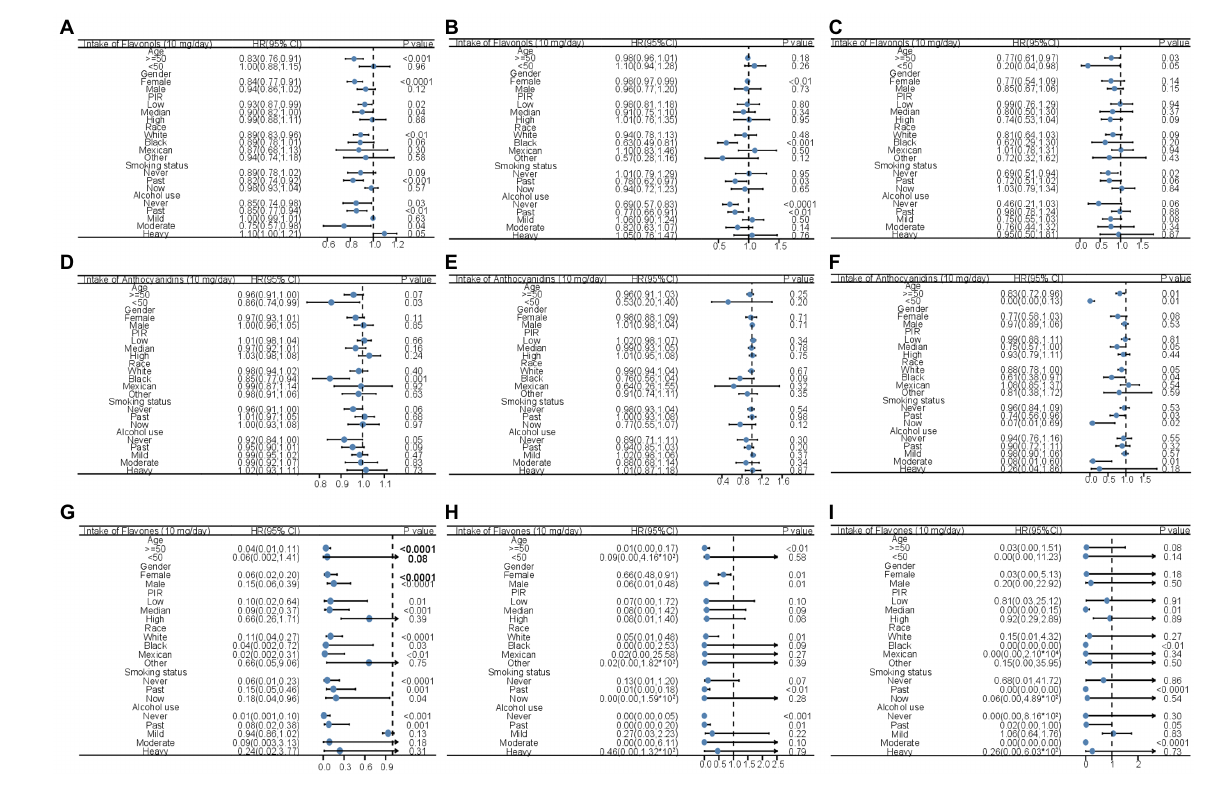
FIGURE 2 Forest plots displaying the association between flavonol intake and all-cause mortality (A) , mortality of heart diseases (B) , and mortality of cerebrovascular diseases (C) ; the association between anthocyanidin intake and all-cause mortality (D) , mortality of heart diseases (E) , and mortality of cerebrovascular diseases (F) ; and the association between flavones intake and all-cause mortality (G) , mortality of heart diseases (H) , and mortality of cerebrovascular diseases (I) in unadjusted Cox analysis stratified by age, gender, PIR, race, smoking status, and alcohol usage with the increment unit of 10 mg/day. HR: Hazard ratios; PIR: poverty income